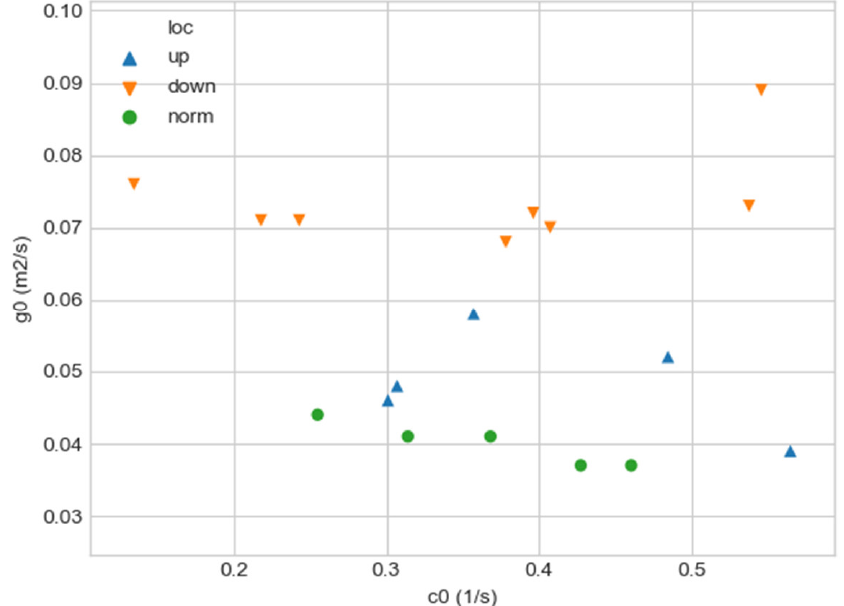
Figure 2. Comparison of C 0 and Γ 0 values for aortas from Table 1. Blue triangles indicate aortas with pathology in the proximal sections, orange triangles—aortas with pathology in the distal sections, and green circles—aortas without severe pathology.